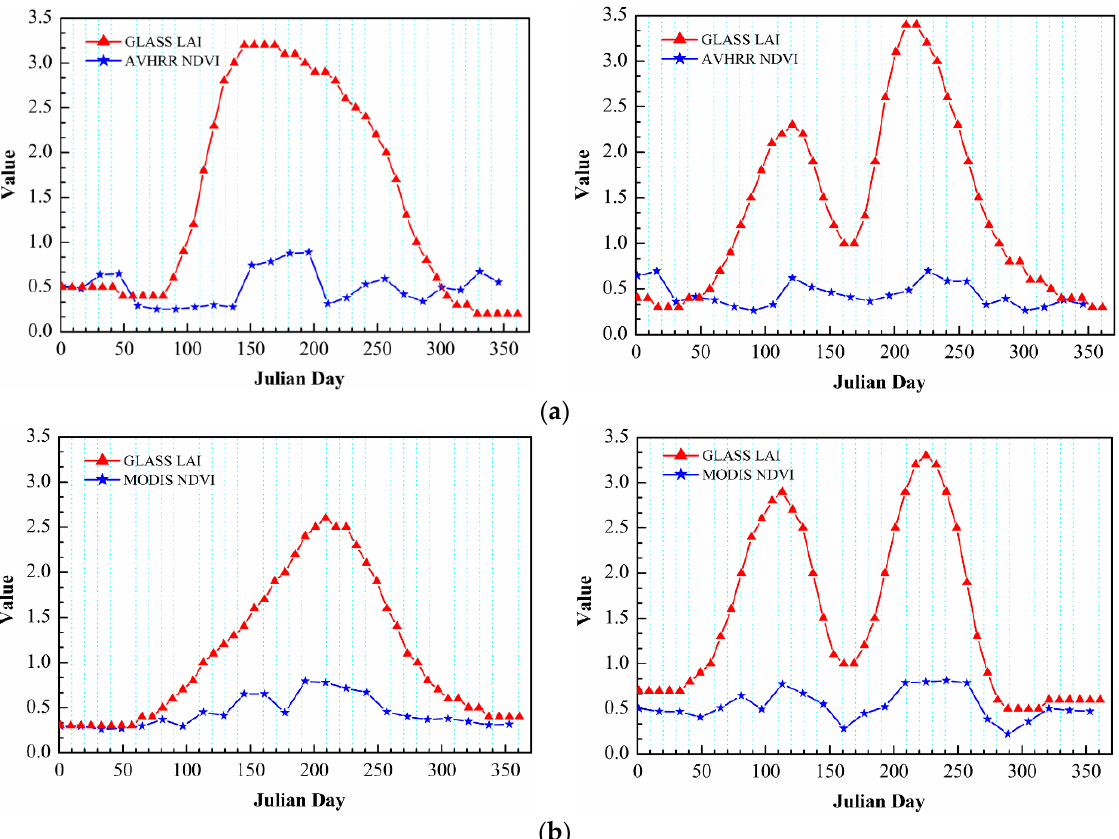
Figure 12. Comparing of Global LAnd Surface Satellite Leaf Area Index (GLASS LAI) with Advanced Very High Resolution Radiometer (AVHRR) and Moderate-resolution Imaging Spectroradiometer (MODIS) Normalized Difference Vegetation Index (NDVI) time series curves in the North China Plain. ( a ) The comparison between GLASS LAI and AVHRR NDVI time series unimodal ( left ) and bimodal ( right ) curves in the NCP; ( b ) the comparison between GLASS LAI and MODIS NDVI time series unimodal ( left ) and bimodal ( right ) curves in the NCP. Table 4. The correlation between land fragmentation and accuracy of extracted Multiple Cropping Indices in each subarea from 1992 to 2007.